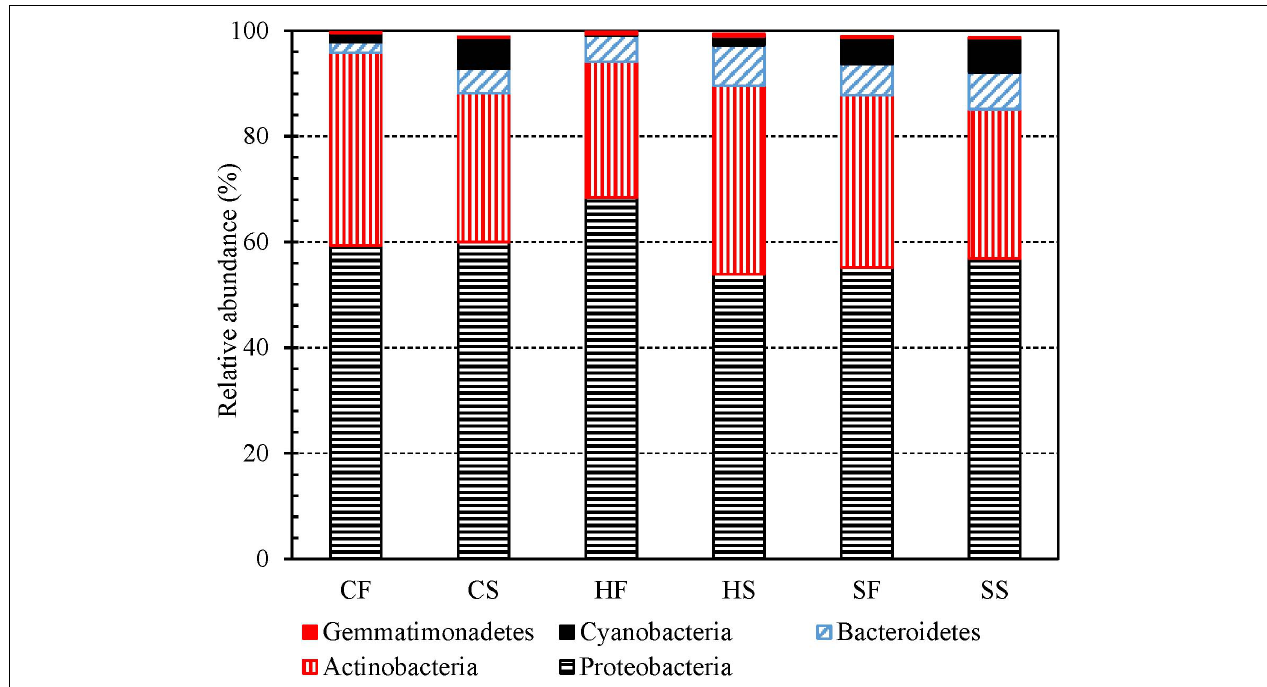
FIGURE 2 | The relative abundance of dominant bacterial phyla in the first and second draws of cold tap, hot tap, and shower water (six groups of water samples). CF : Cold tap water-First draw. CS : Cold tap water-Second draw. HF : Hot tap water-First draw. HS : Hot tap water-Second draw. SF : Shower water-First draw. SS : Shower water-Second draw. We assigned a phylum to each contig for each water sample with Mothur and then calculated the relative abundance of each phlyum for each group of samples. We displayed a phylum only if its relative abundance is greater than 0.50% in at least one